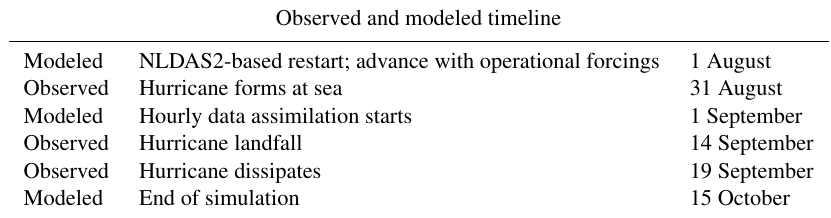
Figure 1. Hurricane Florence model domain showing the river network with locations of the main Cape Fear and Neuse rivers in North Carolina. The assimilated 107 gauges, from USGS, are denoted by gray dots. The red markers denote 12 gauges that are used for diagnostic and validation purposes. The borders between the states of Virginia, North Carolina, and South Carolina are also shown in black. The thickness of the river reaches denote the strength of streamflow (resulting from an open-loop run and averaging over the month of September in 2018), such that larger thickness means higher streamflow. Table 1. Hurricane Florence timeline in the Carolinas, USA, 2018. NLDAS-2 denotes the forcing data for phase 2 of the North American Land Data Assimilation